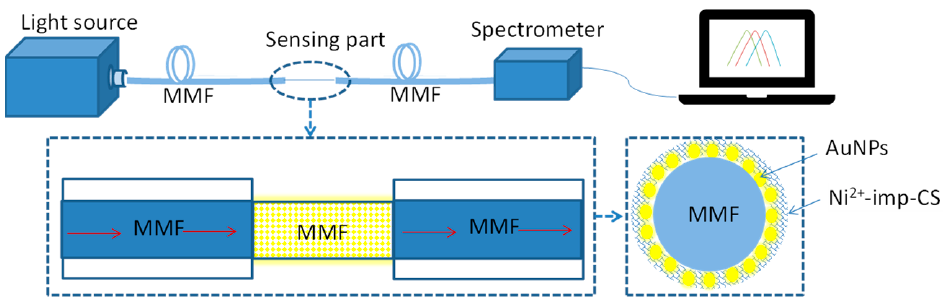
Figure 2. Experimental setup of the proposed Ni 2+ sensor based on LSPR. MMF: Multi-mode fiber; AuNPs: Au nanoparticles; Ni 2+ -imp-CS: Ni 2+ imprinted chitosan.